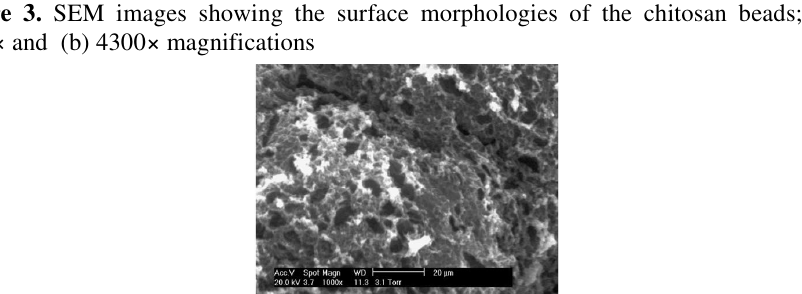
Figure 4. ESEM microphotograph of cross-linked chitosan bead (X